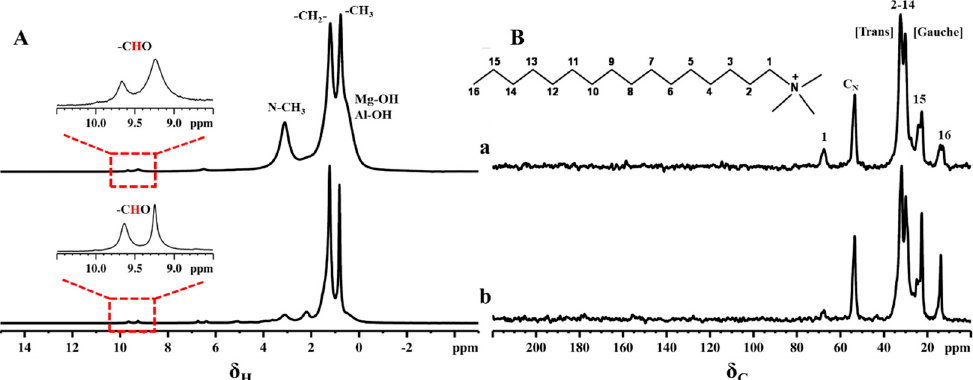
Figure 7. 1 H ECHO ( A ) and 13 C CPMAS ( B ) NMR spectra of CTASapC6AN (a) and CTASapC7AN (b) samples. (b)